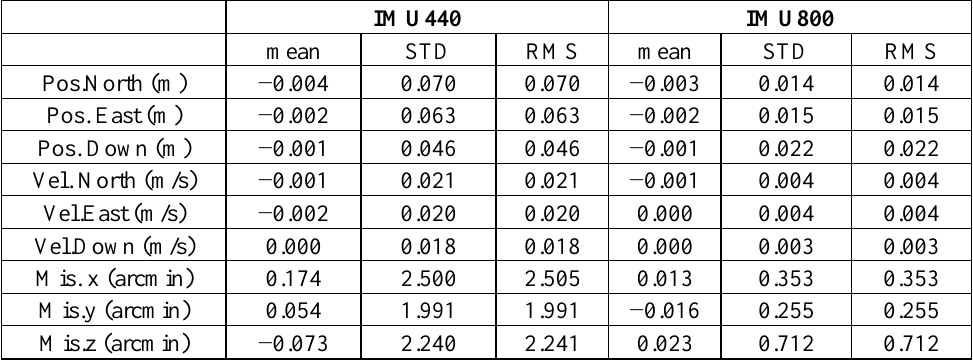
Table 3. Statistics for error states in loosely-coupled GPS/IMU Kalman